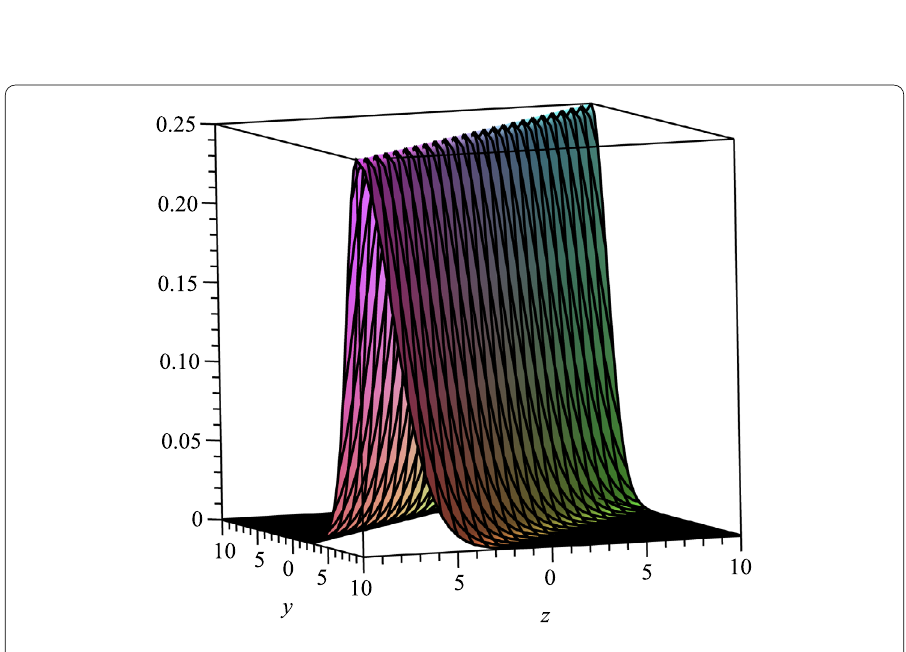
of the mZK equation with k = 1. The evolutions of solution (34) are given in Fig. 1, Fig. 2, and Fig. 3,